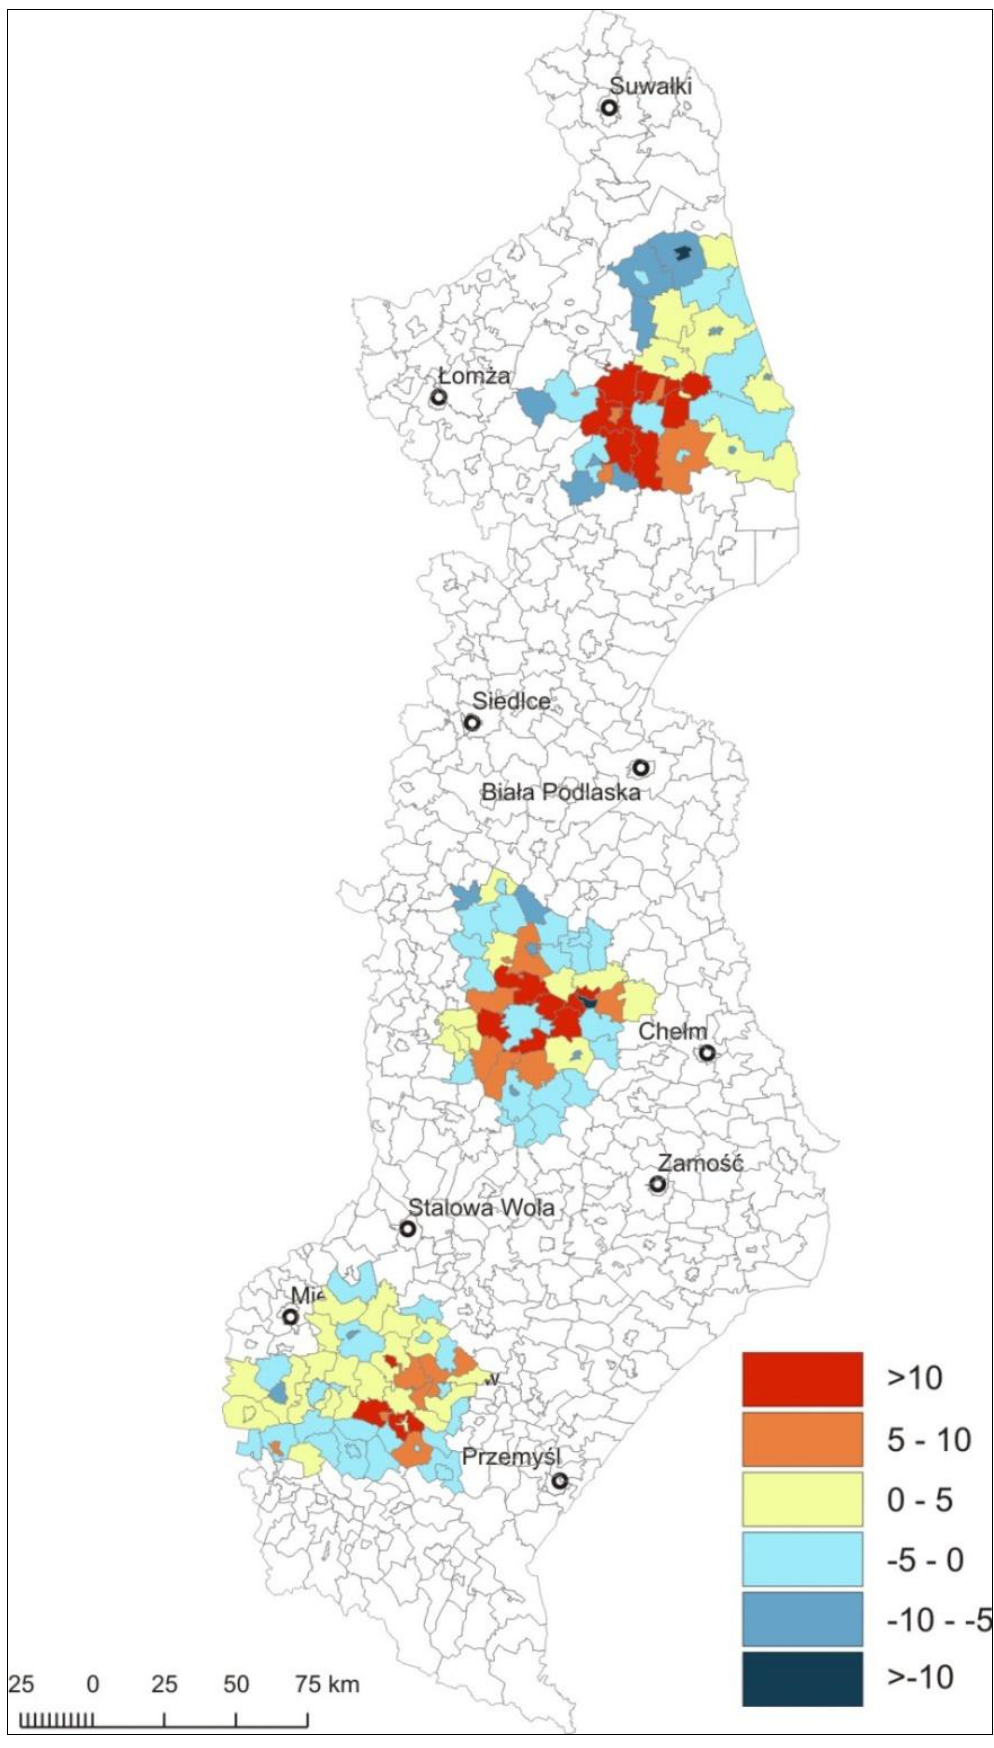
Fig. 5. Migration balance per 1000 people in the Białystok, Lublin and Rzeszów Metropolitan Areas (2014) (author’s own elaboration based on data of the Local Data Bank of the Central Statistical